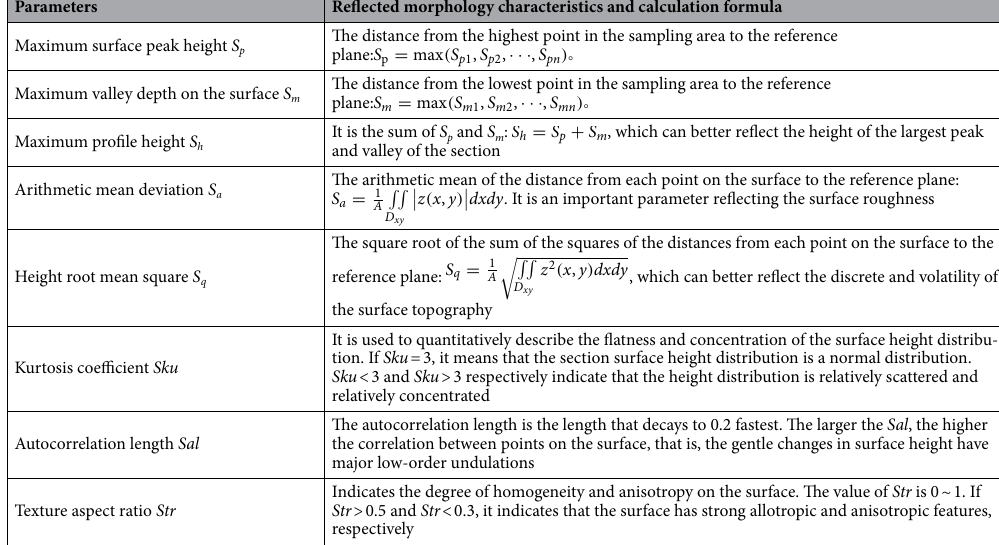
Table 5. Three-dimensional profile characteristic parameters. S pi and S mj (i = 1, 2,…, n) in the table are the distances from all contour peaks and contour peak valleys to the reference plane respectively, and A is the area of the sampling area.